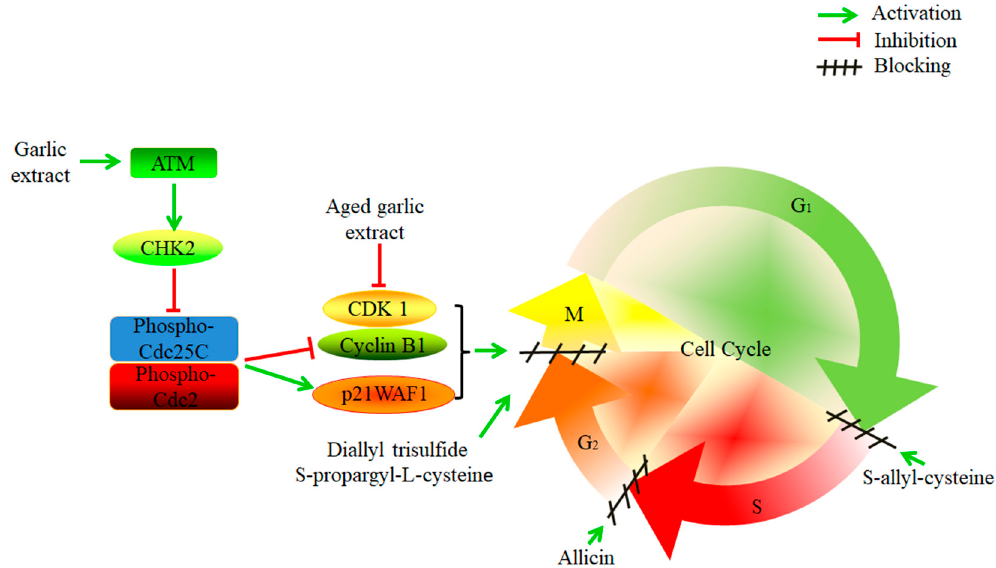
Figure 3. The mechanisms of garlic and its active compounds on the inhibition of the cell cycle in cancer cells. Garlic extract activated ataxia-telangiectasia mutated (ATM) and checkpoint kinase 2 (CHK2), and inhibited the phosphorylation of Cdc25C and Cdc2, which down-regulated cyclin B1 and up-regulating p21WAF1, thereby inhibiting the cell cycle in the G 2 / M-phase. Aged garlic extract can down-regulate Cyclin B1 and Cyclin-dependent kinase 1 (CDK1) and block the cell cycle in the G 2 / M-phase. Diallyl trisulfide and S-propargyl- l -cysteine can also block the cell cycle in the G 2 / M-phase. Moreover, S-allyl-cysteine induced cell cycle arrest in the G 1 / S-phase, and allicin induced cell cycle arrest during the S-phase.